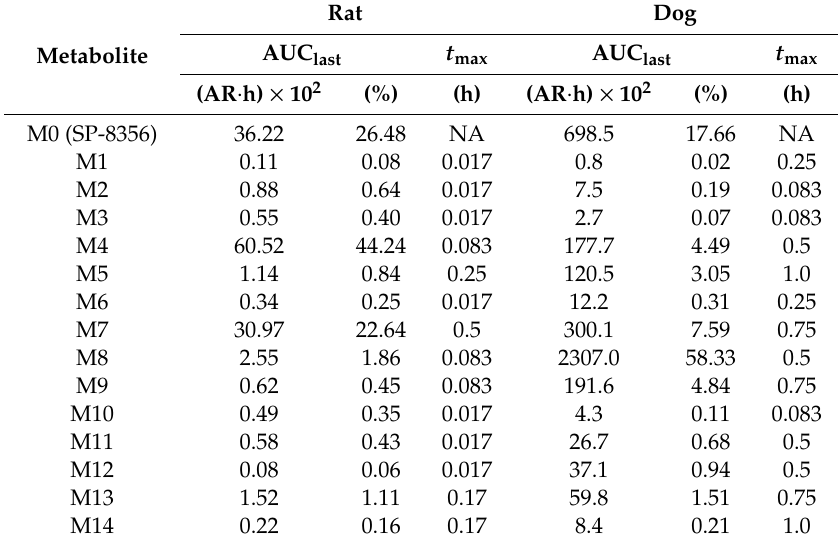
Table 3. Plasma exposure of SP-8356 and its putative metabolites detected in rat and dog plasma.